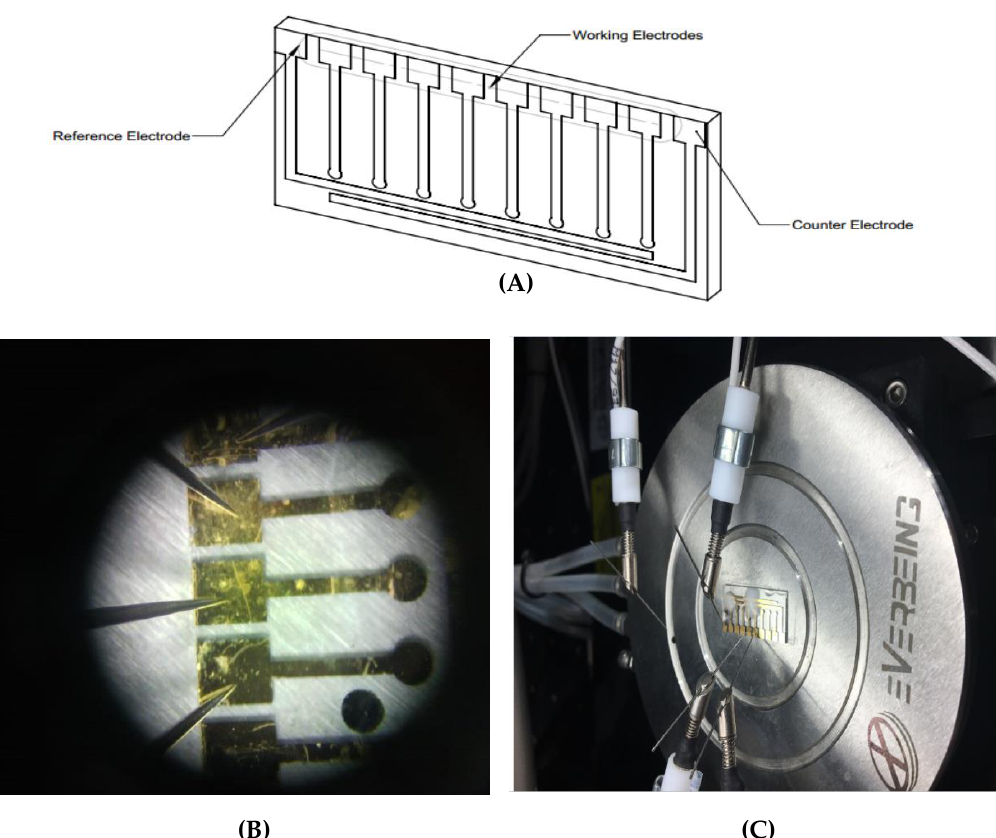
Figure 1. ( A ) Illustration of electrodes. ( B ) A picture of electrodes. ( C ) Electrochemical measurement set up of Keithley-4200 semi-conductor parameter analyzer KTE I version (V9.1).